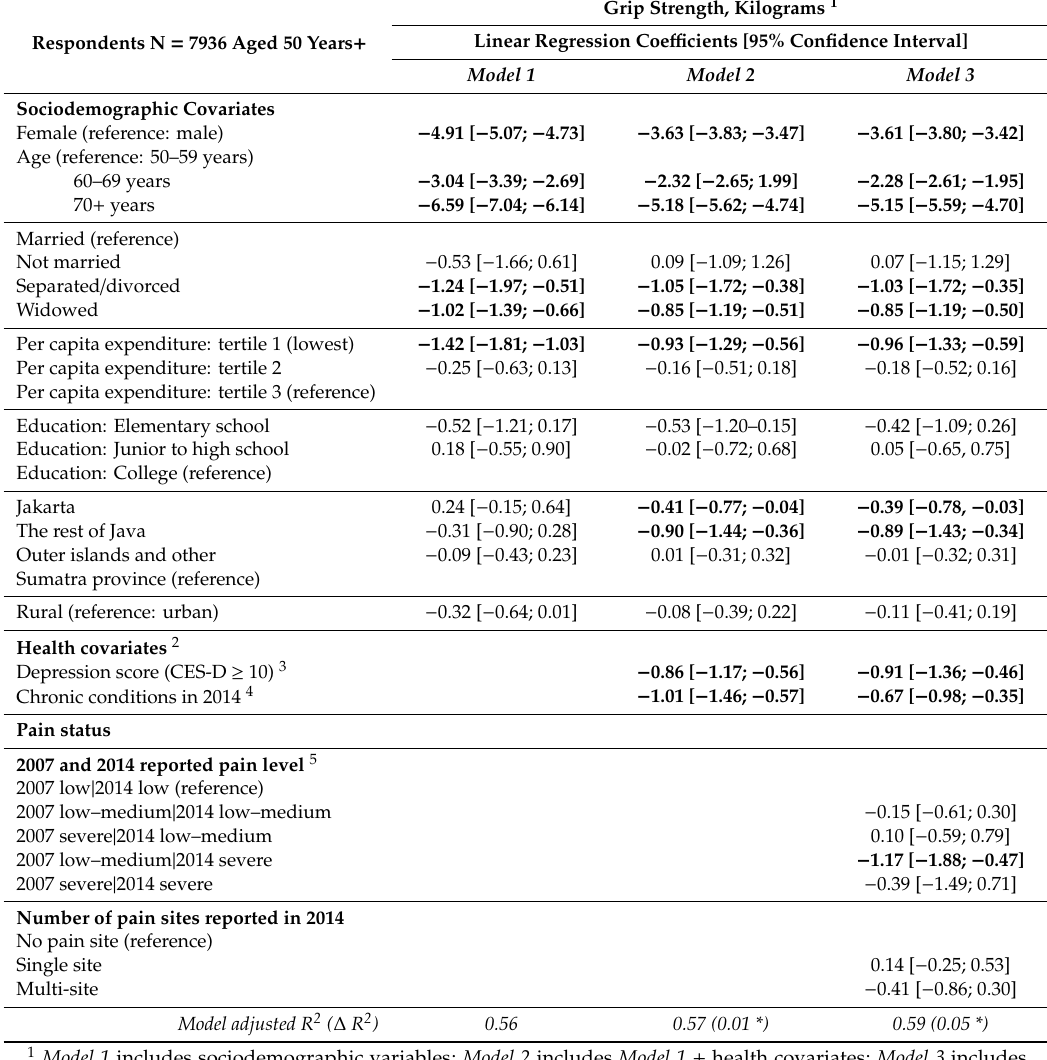
Table 4. Pain status (2007 and 2014) and grip strength (2014), IFLS 2007 and